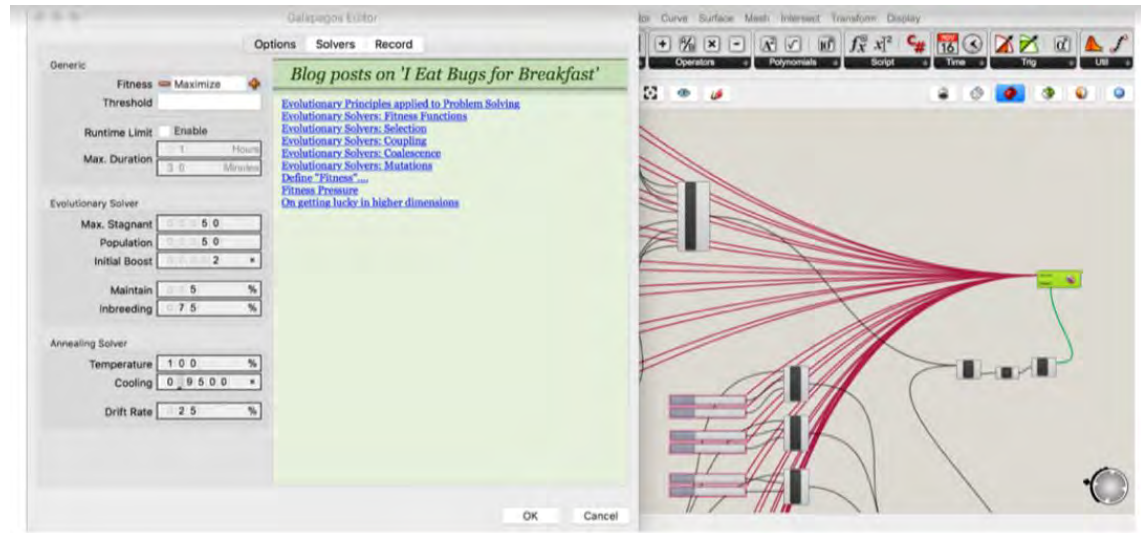
Figure 10. Options provided by